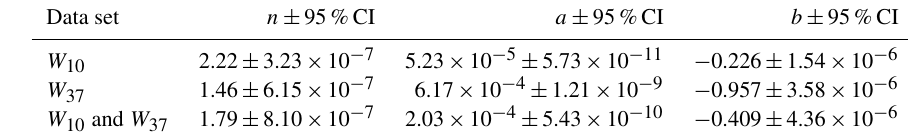
Table 2. Regression coefficients n , a , and b with 95% CIs derived as free parameters from fitting Eq. (6) to different global data sets.